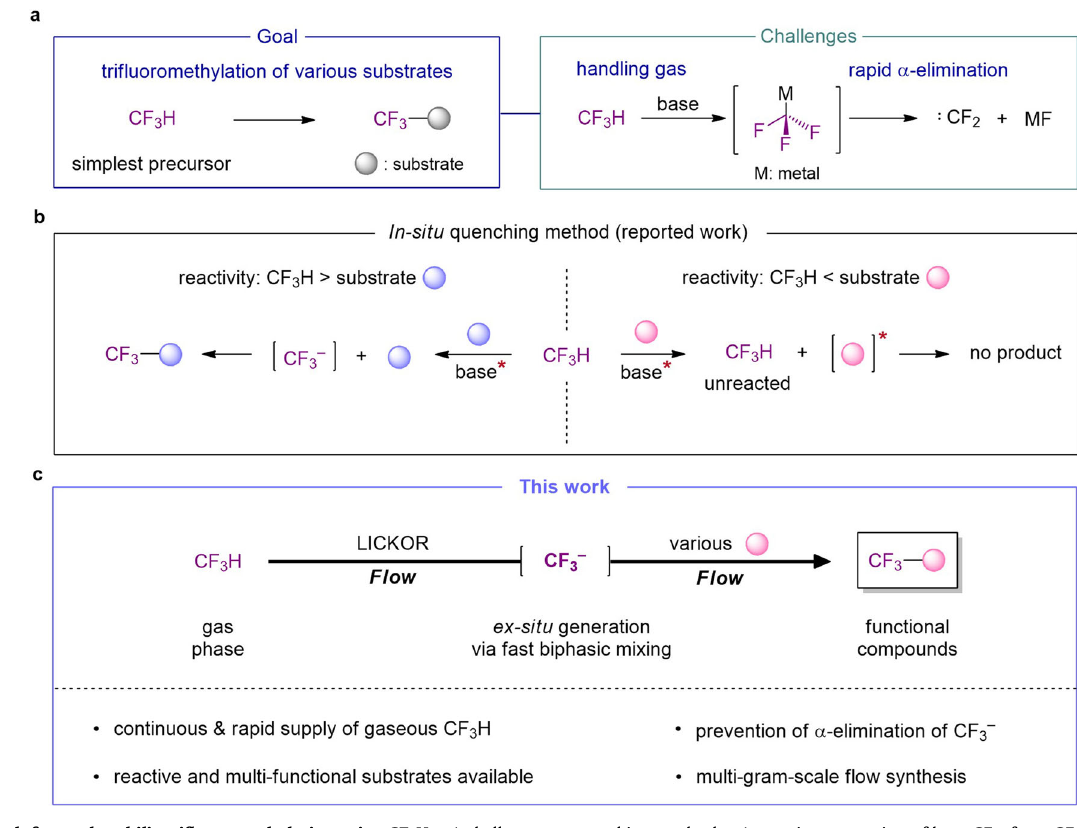
quenching method. c An ex situ generation of bare CF 3 − from CF 3 H using LICKOR type of superbase via fast gas-liquid mixing in fl ow (this